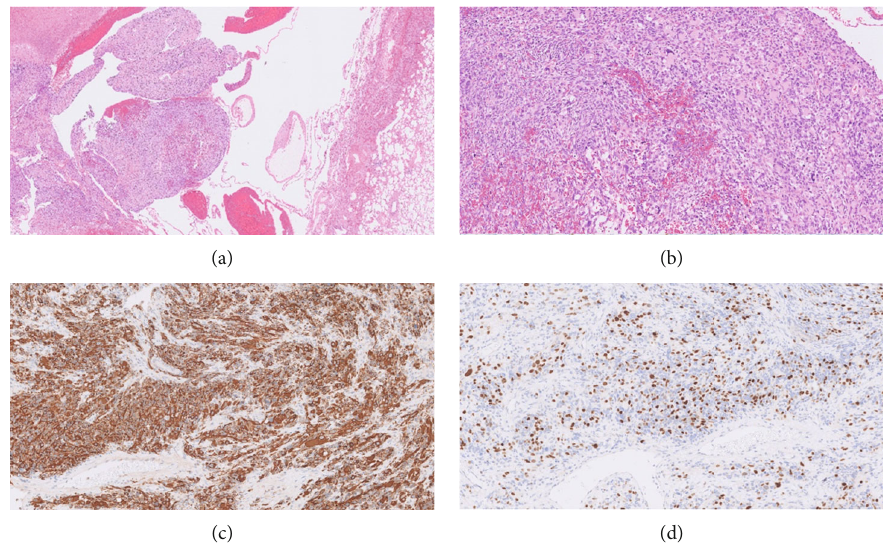
Figure 4: (a) Solid and cystic components of the tumor (low de fi nition with hematoxylin and eosin stain). (b) Atypical rhabdomyoblasts in solid component (high de fi nition with hematoxylin and eosin stain). (c) Di ff use strong cytoplasmic expression with desmin stain. (d) Myogenin nuclear expression in